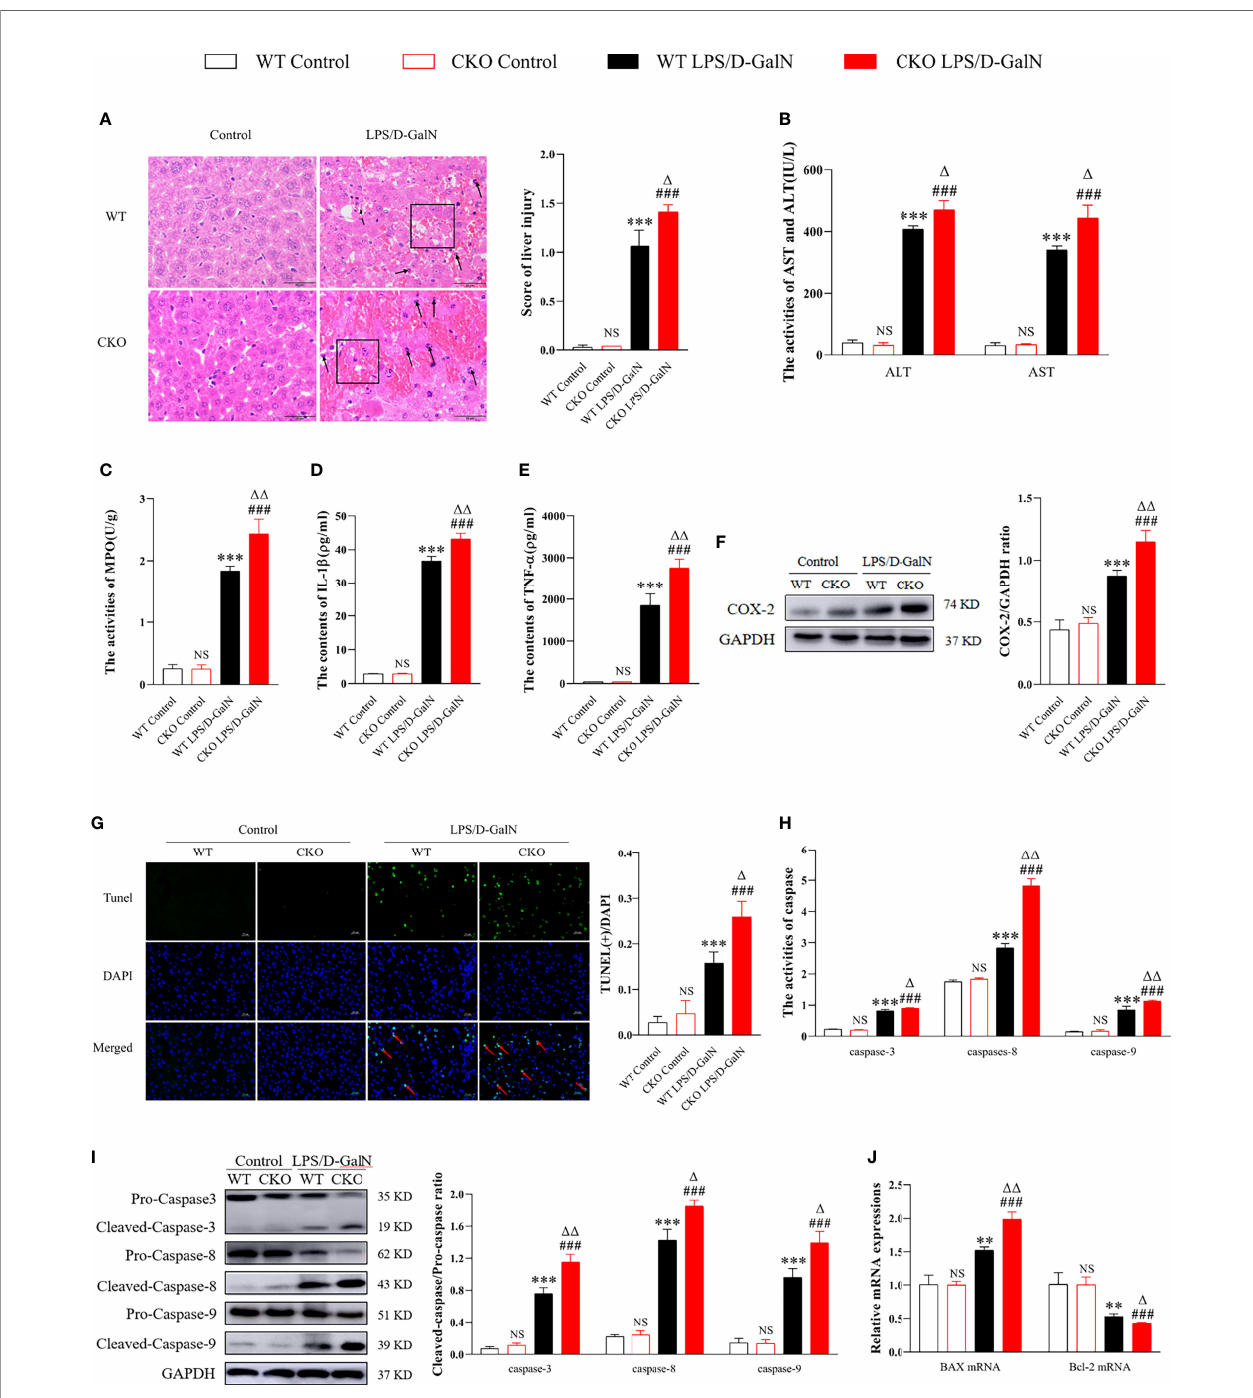
FIGURE 2 | PEBP4 CKO could aggravate LPS/D-GalN – induced ALI. (A) : Histological changes of liver tissue (H&E staining, ×400) and the injury scores of HE were quanti fi es, ↑ for in fl ammatory cell in fi ltration, □ for hepatocyte degeneration and red blood cell in fi ltration. (B) : We detected the activities of AST and ALT in serum (n = 6). (C) : MPO activities were tested in liver tissue (n = 6). (D, E) : The levels of IL-1 b and TNF- a in serum were detected by ELISA (n = 6); (F) : Western blot was used to examine the expression of COX-2 (n = 3). (G) : The apoptotic level of hepatocytes was detected with a TUNEL fl uorescence detection kit (the DAPI-stained nuclei were blue and apoptotic nuclei were green, ×400) and positive cells of TUNEL were quanti fi ed, ↑ for TUNEL (+) cells. ( H, I) . The activities and protein expression of caspase-3, -8, and -9 were detected by the activity test kit (n = 6) and western blotting (n = 3), respectively; (J) . The mRNA expression levels of Bax and Bcl-2 were detected by real-time PCR. Data are presented as mean ± SD values. NS P > 0.05, ** P < 0.01, and *** P < 0.001 compared to the WT control group; ### P < 0.001 compared to the CKO control group; and D P < 0.05 and DD P < 0.01 compared to the WT LPS/D-GalN